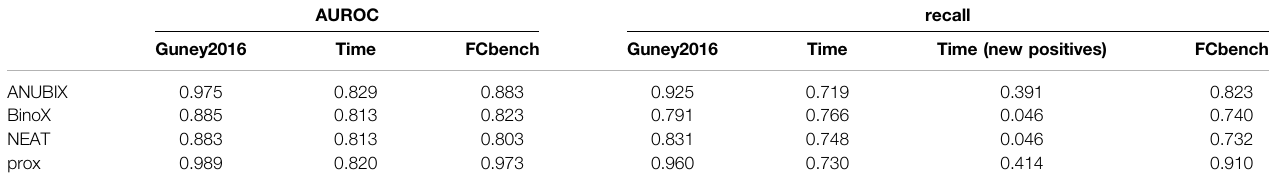
TABLE 2 | Drug – drug similarity – based performance metrics for all three benchmarks. Performance on the three benchmarks, Guney 2016, time-stamped (time), and FCbench, was assessed for different drug repurposing tools: ANUBIX, BinoX, NEAT, and proximity (prox). The evaluated metrics included AUROC, recall, and recall on the pairs in the time-stamped benchmark (new positives).